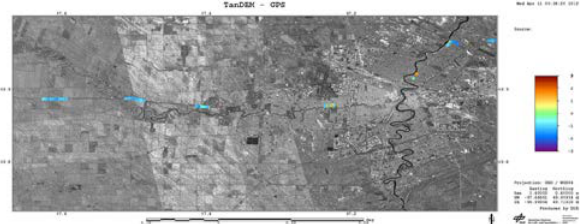
Figure 2: Difference between TanDEM-X and GPS on amplitude mosaick, North-Eastern part of tile N49W98 - area around Winnipeg, range of values [-3; 3]